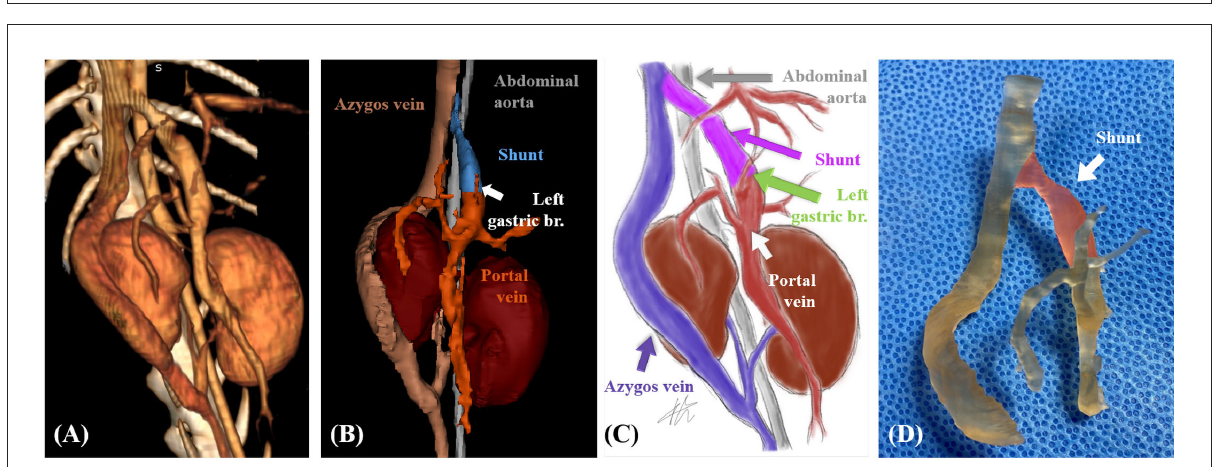
FIGURE2 Case 1. Volume-rendered three-dimensional (3D) projection of the computed tomography (CT) angiography study (A) . Surface-rendered 3D projection of the CT angiography study (B) . Illustrations of vascular anomaly (C) . 3D printed vascular model (areas marked in transparent red color indicate shunt) (D)